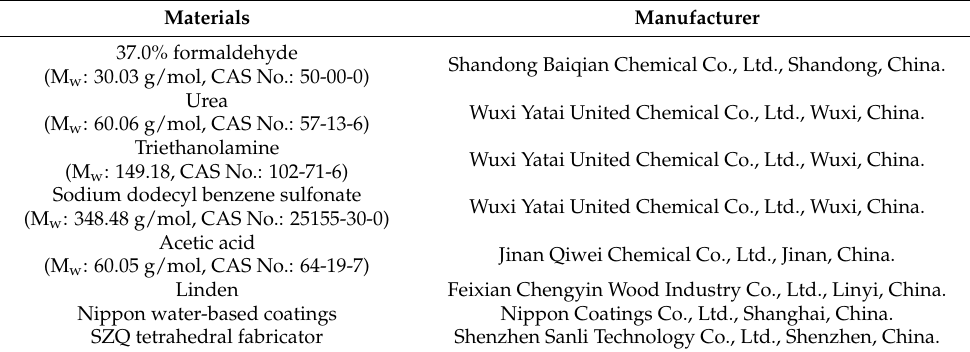
Table 1. Experimental